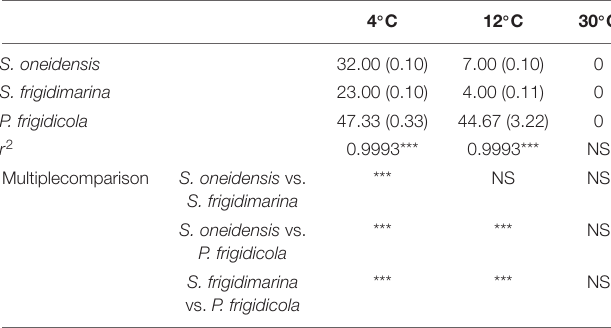
Data are expressed as mean ± (SD). Statistical differences were studied by ANOVA test (***p ≤ 0.0001). Statistical significance was achieved by Bonferroni’s post-test (NS, not significant;***p ≤